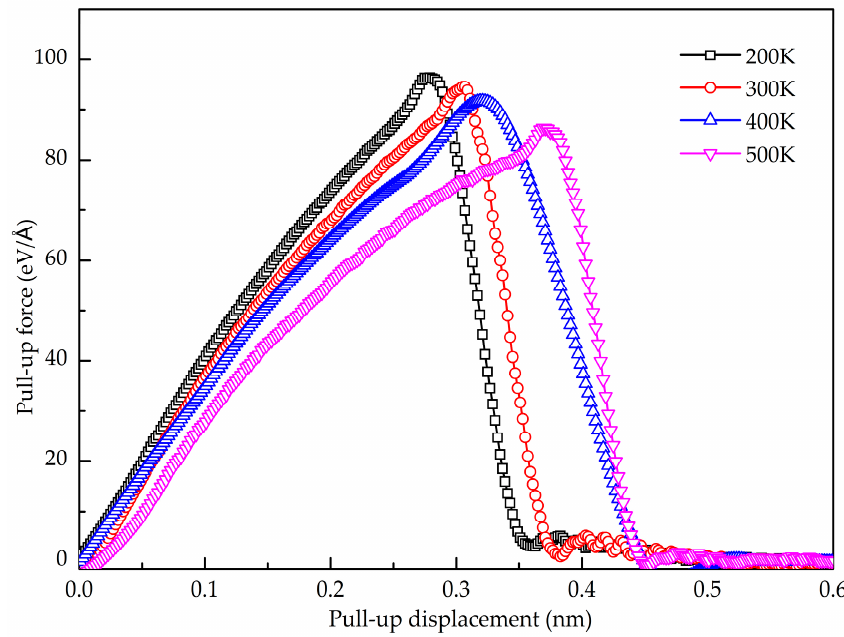
Figure 4. Pull-up force-displacement curve of the GANC at different temperatures.